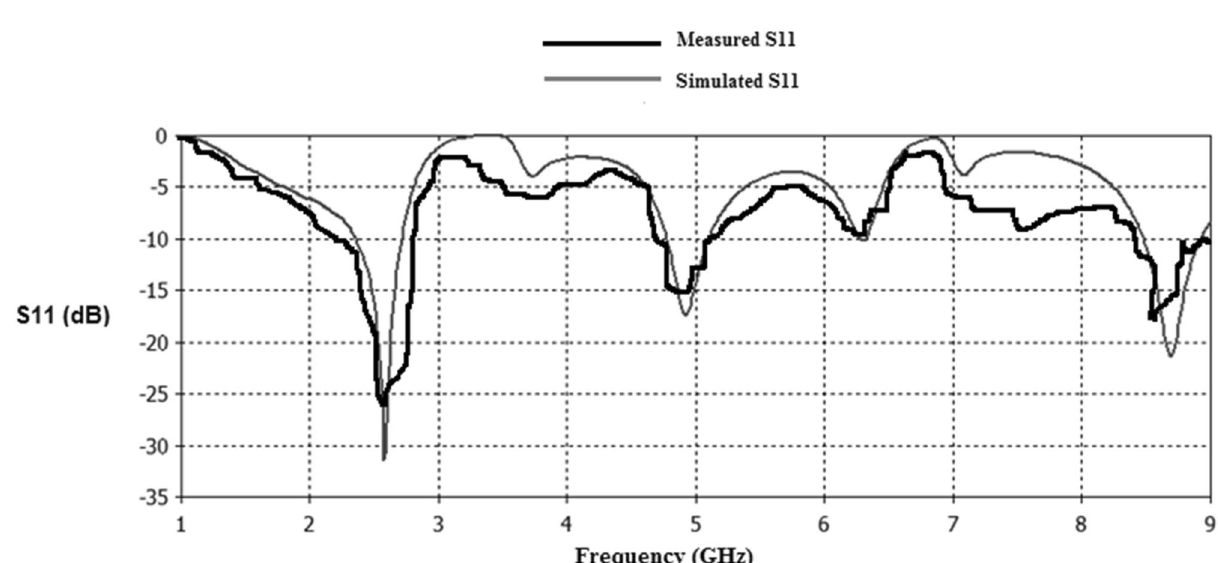
Figure 28. Simulated and measured S11 responses of